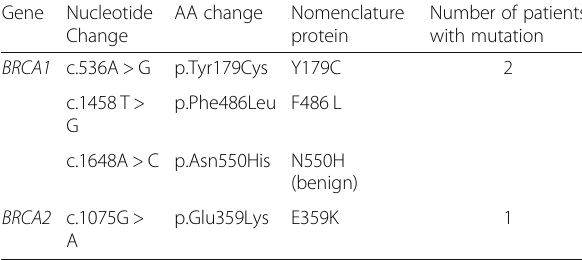
Table 2 Pathogenic BRCA gene mutations detected in the cohort Gene Nucleotide Change